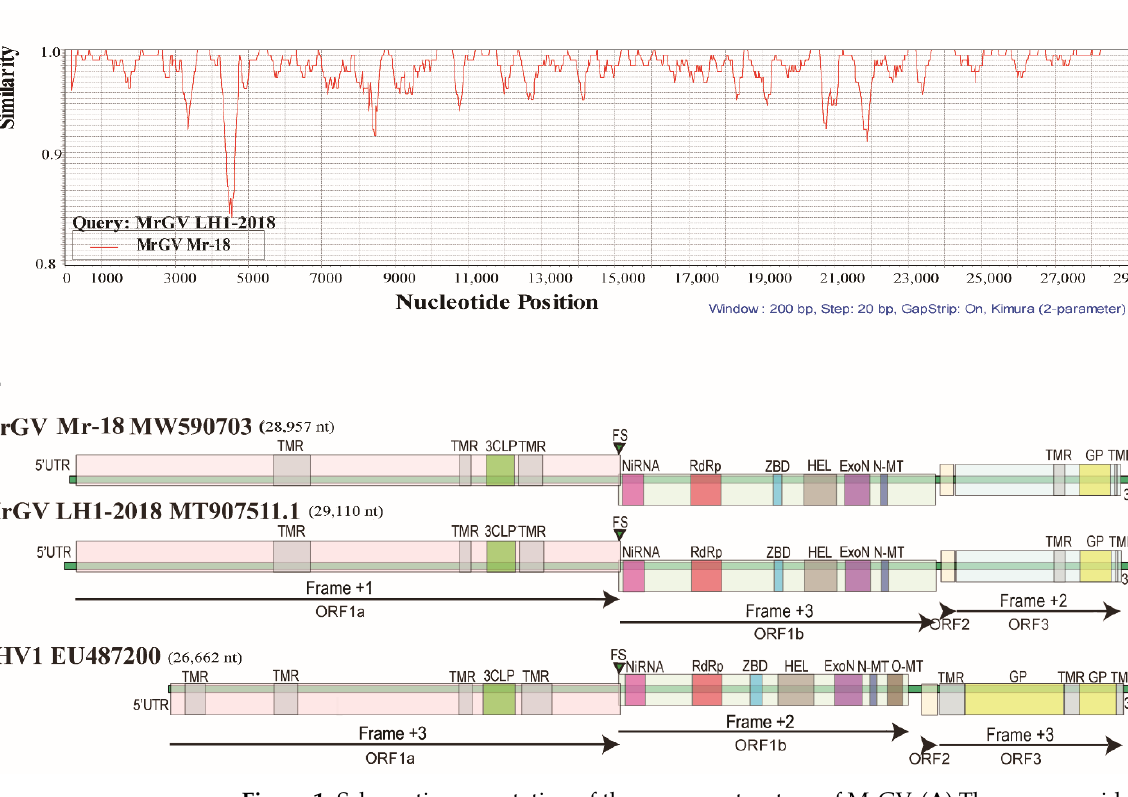
Figure 1. Schematic presentation of the genome structure of MrGV. ( A ) The sequence identity and ( B ) the conserved protein domains of yellow head virus (YHV), Macrobrachium rosenbergii